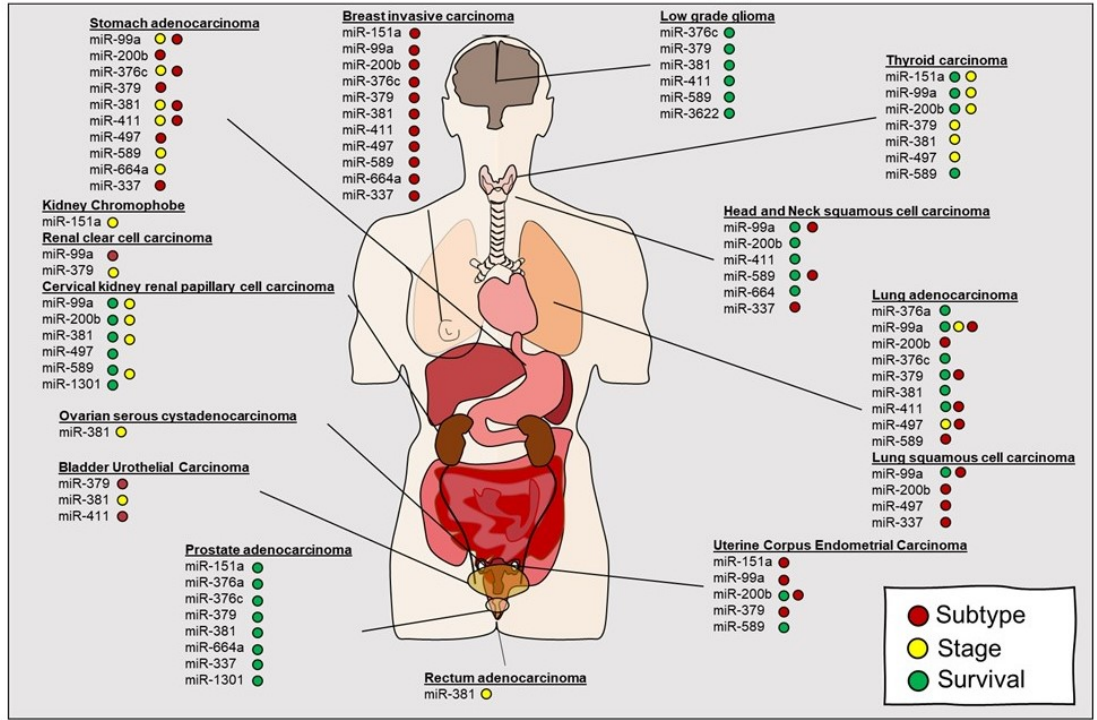
Figure 4. Schematic representation of miRNA editing hotspots in cancer correlated with key variables including survival, stage, and subtype. (Wang et al 2017).